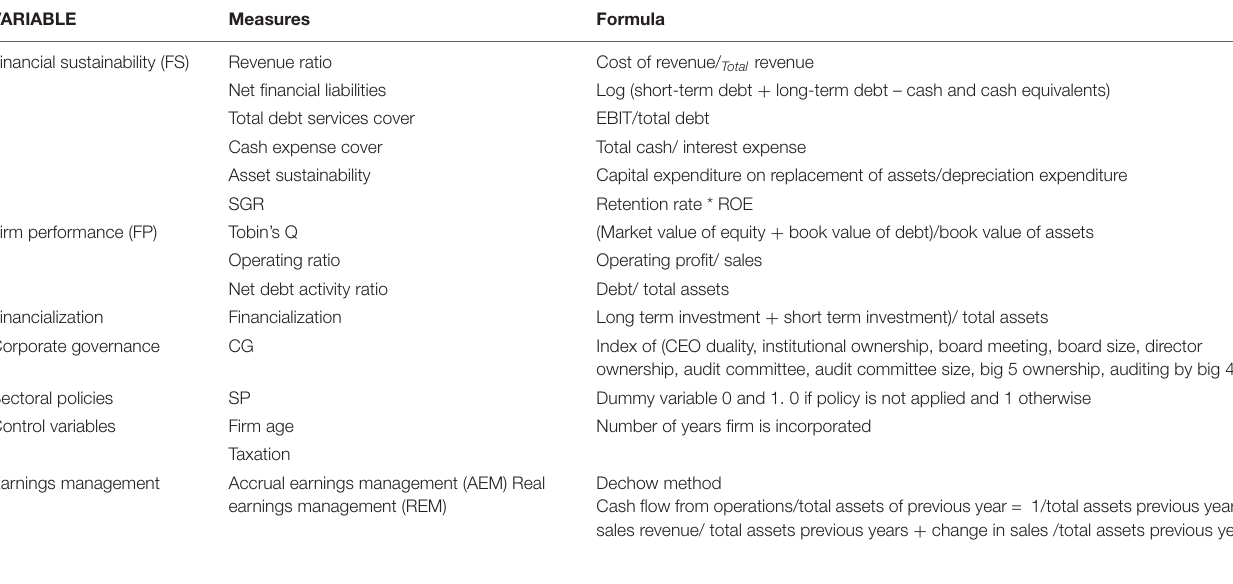
TABLE 1 | Variables and their